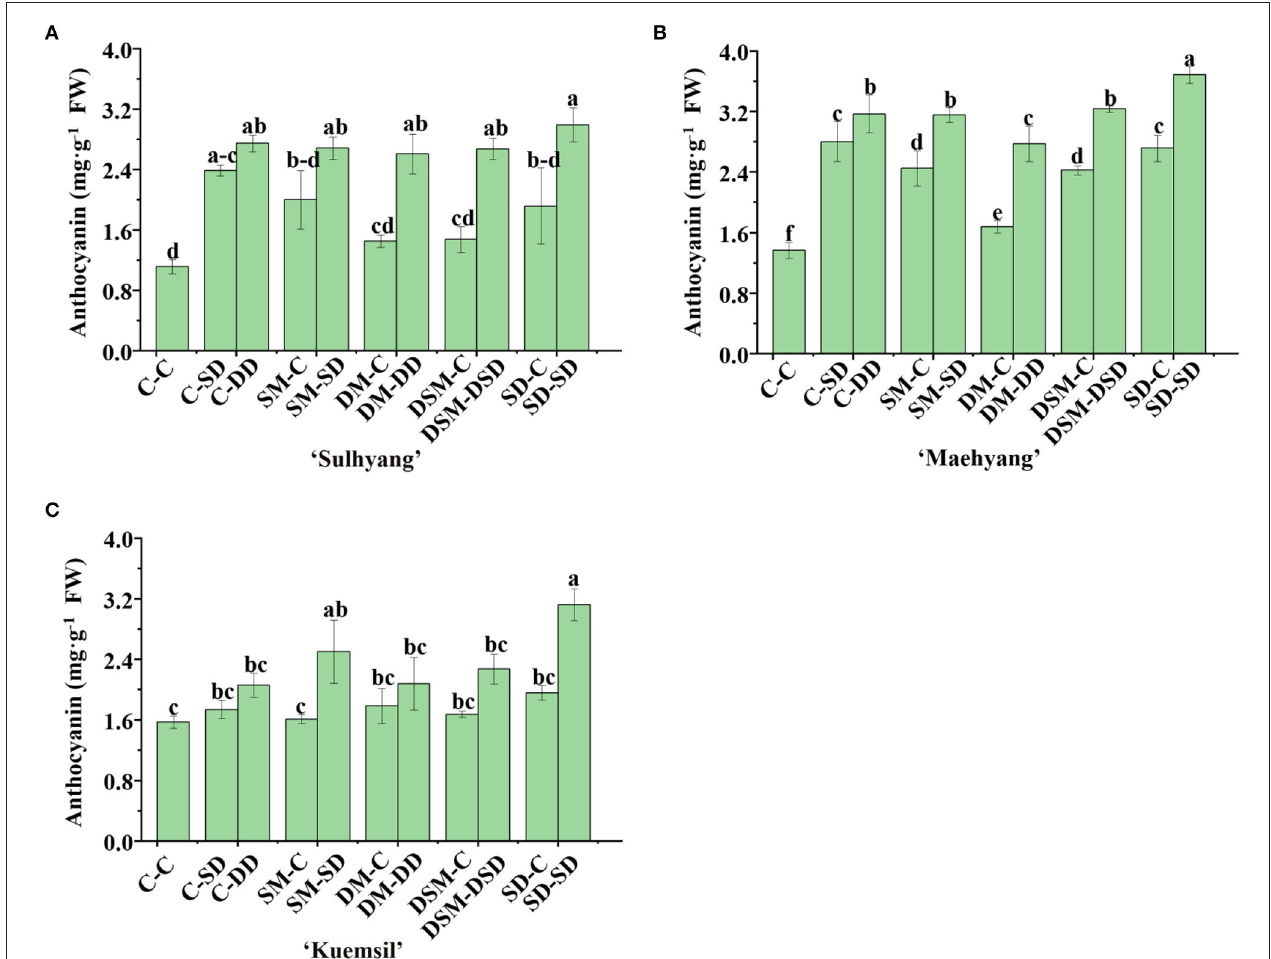
FIGURE 14 | Anthocyanin content in leaves of strawberry transplants (A) “Sulhyang”; (B) “Maehyang”; and (C) “Kuemsil” as affected by the Si treatment after subjection to 43 ◦ C for 7 days. Lowercase letters indicate significant differences calculated by the Duncan’s multiple range test at p ≤ 0.05. See Figure 1 for descriptions of treatment